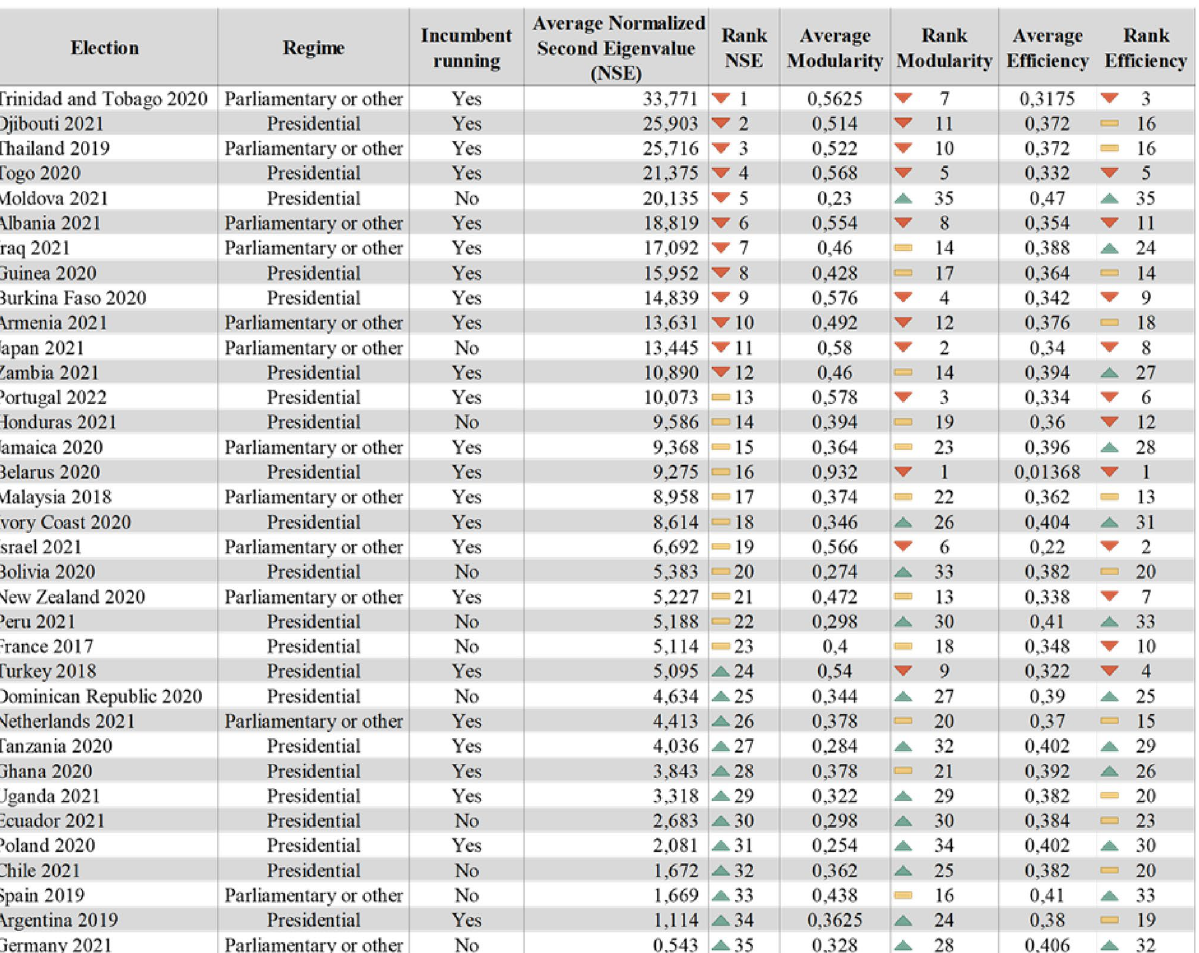
Figure 2. Average of the measures by election. The icons on the rankings are placed according to the effect of the variable on the convergence (higher values of the second eigenvalue are related with a slow convergence, like high values of modularity and lower values of